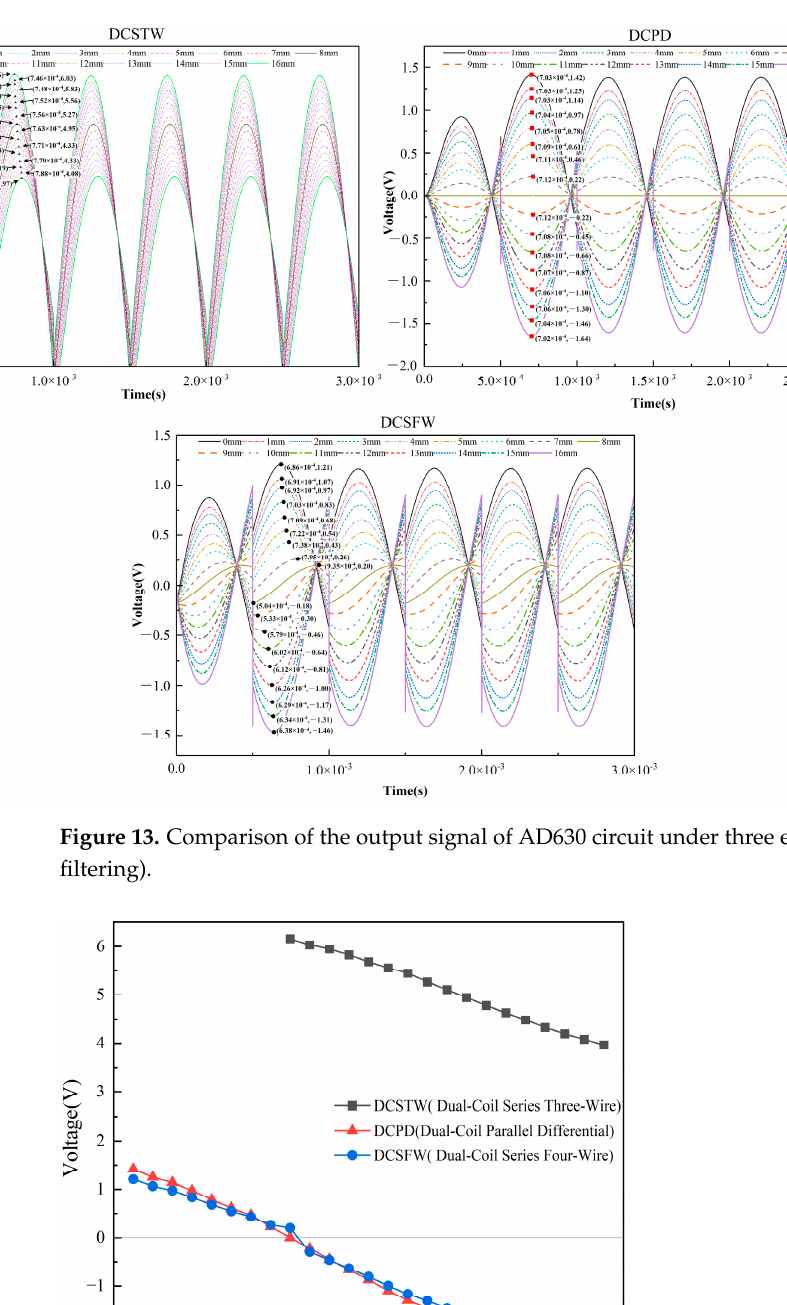
Figure 14. Variation in the amplitude of the output signal of the AD630 circuit.